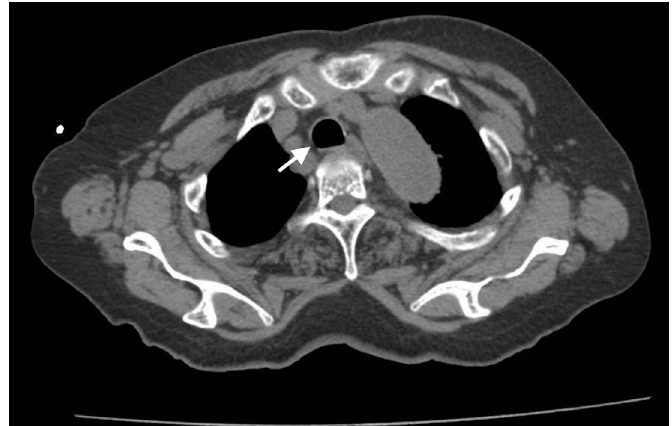
Image 2. Repeated computed tomography with normal trachea